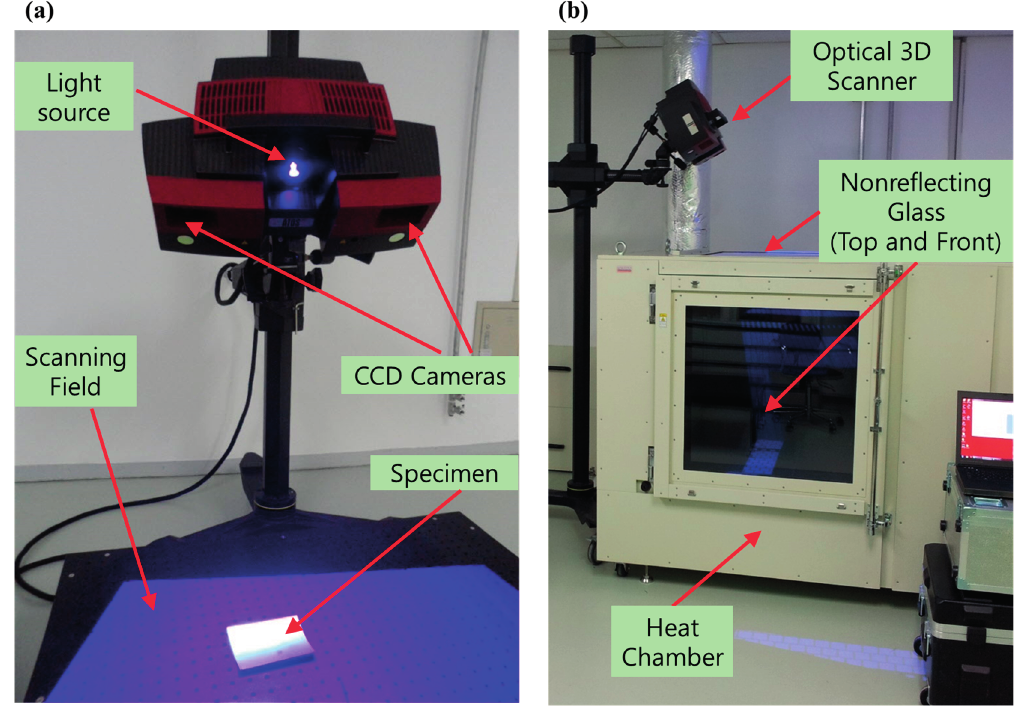
Figure 4. ( a ) Specimen contour measurement using an optical 3D scanner; and ( b ) In situ measurement using a heating chamber with nonreflecting